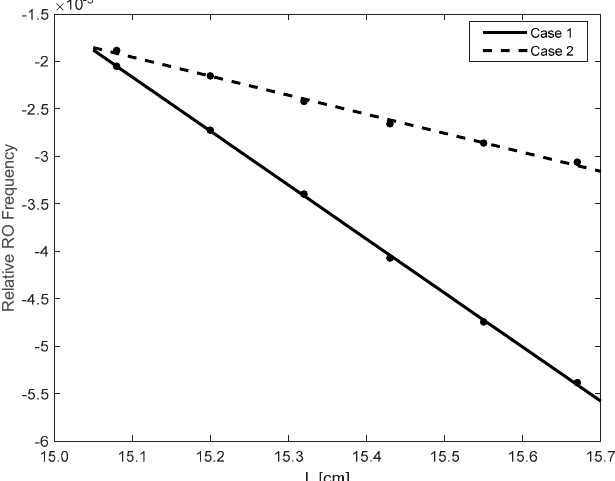
Figure 4. Relationship between the relative relaxation oscillation (RO) frequency difference and the external cavity length L.